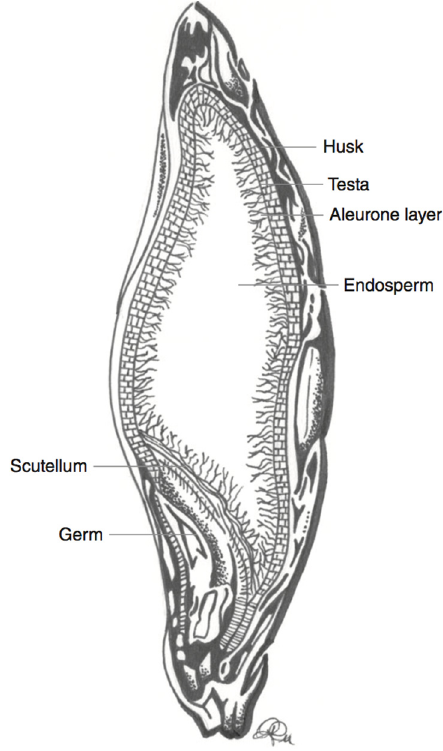
Figure3. Schematicrepresentationofabarleykernelcross-section, withcomponentparts. Adaptedfrom Figure 3. Schematic representation of a barley kernel cross ‐ section, with component parts. Adapted reference [27]. from reference [27]. Table 2. Selection of studies focusing on total anthocyanin content (TAC) in various barley cultivars. The anthocyanin quantification method and assay used for antioxidant potential are also